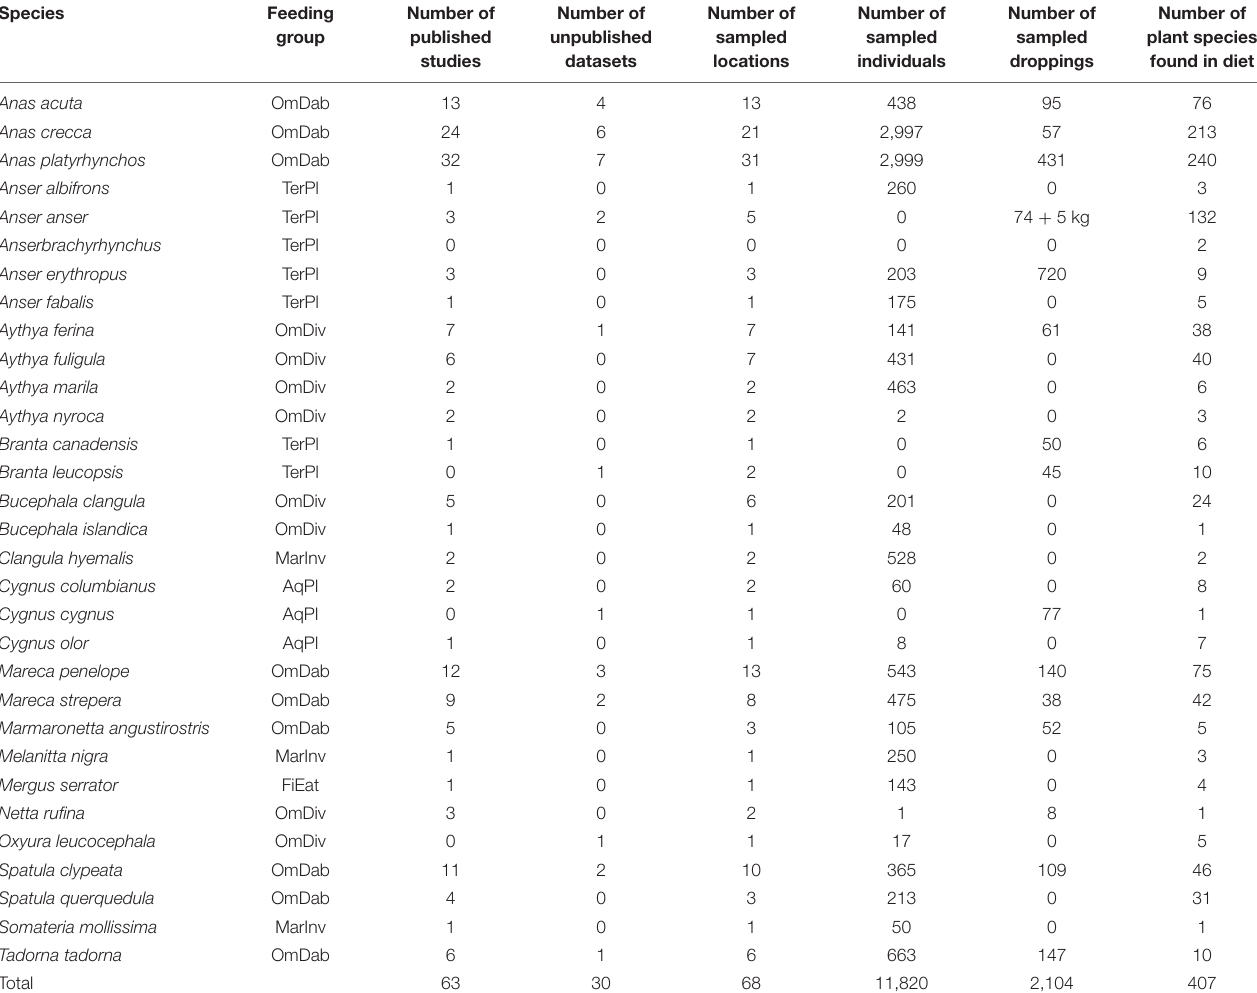
TABLE 1 | Anatidae species for which seed ingestion data was found, their feeding groups (i.e., guilds), and information on the numbers of published studies found in our literature search (see Supplementary Material 1 for details), unpublished datasets used, locations for which data were found, sampled individuals, and plant species whose seeds were ingested by each bird